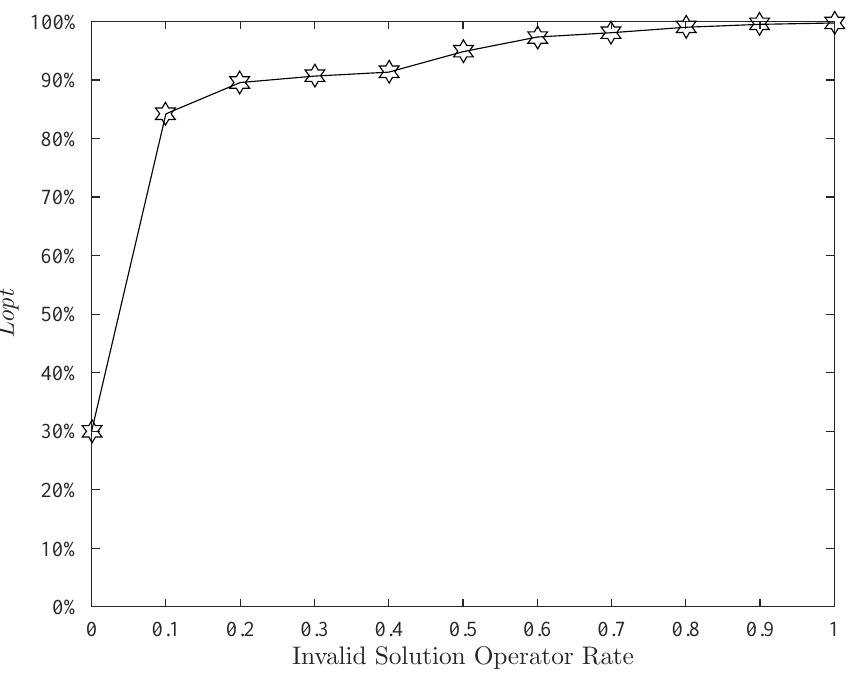
Figure 14. Effect of the invalid solution operator rate.